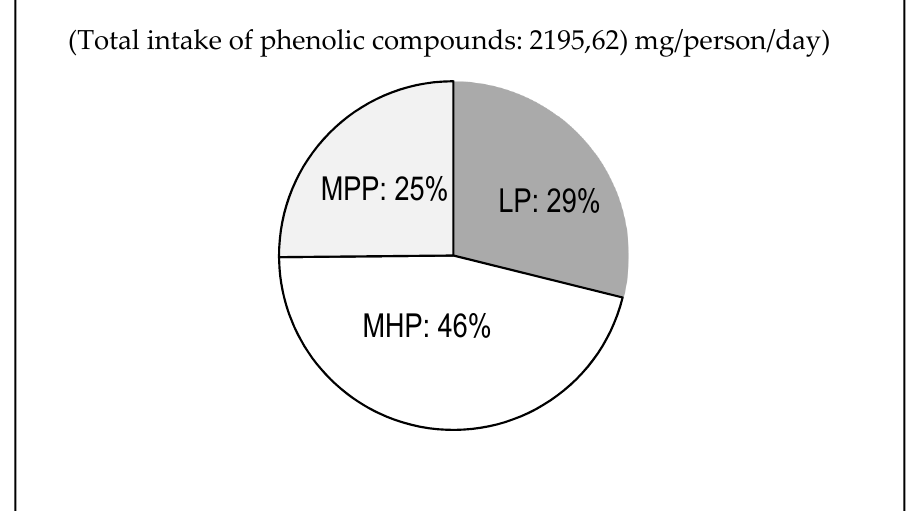
Figure 1. Contribution of macromolecular polyphenols to the daily intake (LP: Low molecular polyphenols; MHP: Molecular hydrolysable polyphenols; MPP: Macromolecular polymeric polyphenols).